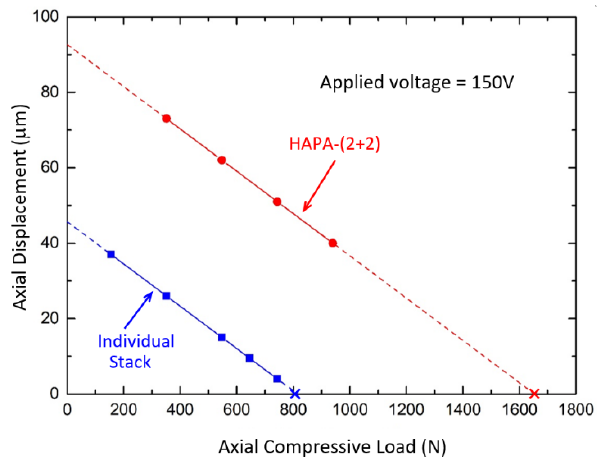
Figure 7. Displacement versus axial compressive load for an NEC-Tokin piezoceramic stack (Model AE0505D44H40DF) and the fabricated HAPA-(2 + 2) actuator, both being driven at 150 V. The crosses on the abscissa mark the blocking forces of respective actuators at said applied voltage.